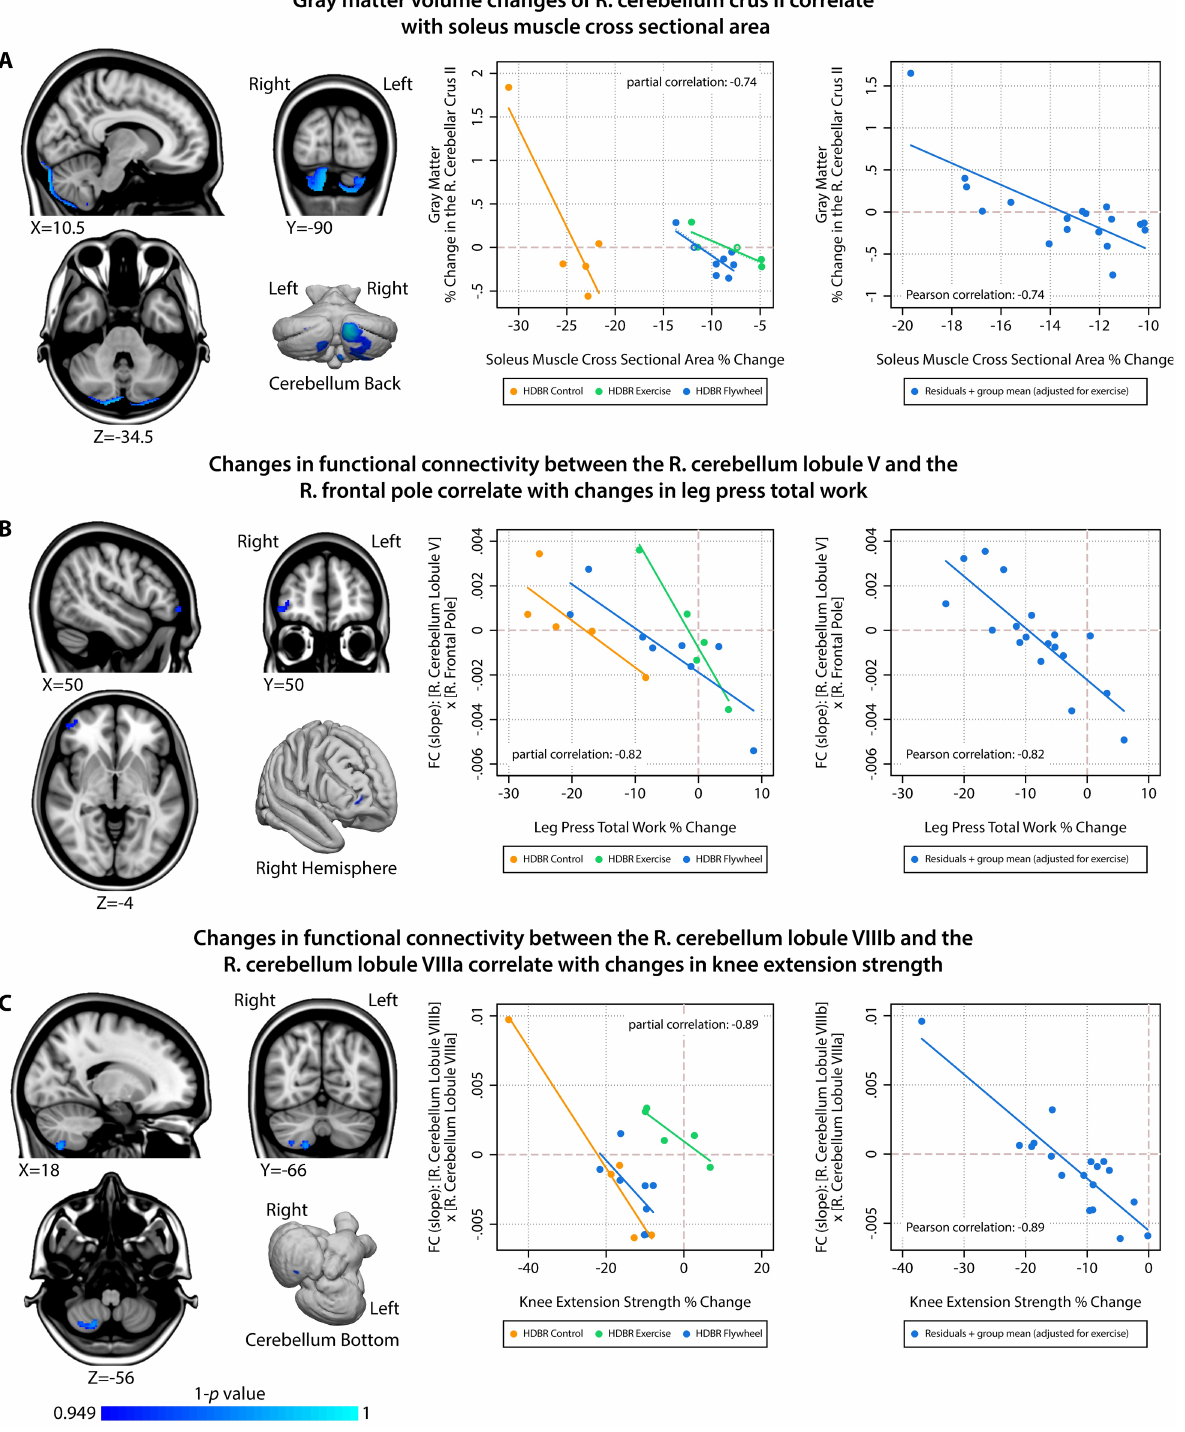
Fig 4. Associations between HDBR-induced changes in brain outcome measures and changes in physical fitness (part 1). Left column = overview of locations showing significant associations between changes in physical fitness and changes in brain measures; Middle column = scatterplot with fit lines showing correlations at the peak voxel stratified by HDBR group; Right column = scatterplot with fit line showing correlations at the peak voxel adjusted for exercise; R. = Right; FC = Functional Connectivity.